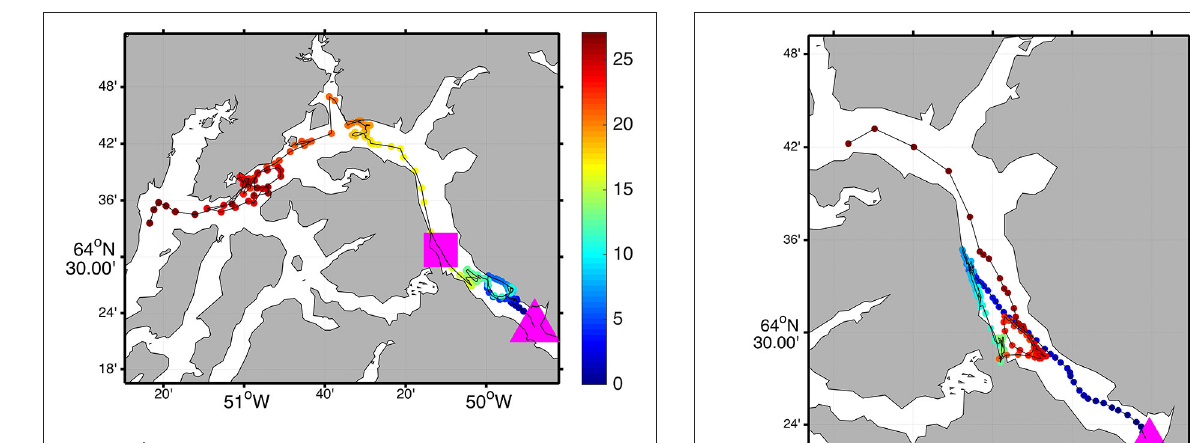
FIGURE 9 | A trajectory of an EXITE beacon initially deployed at the large pink triangle. Locations are color-coded according to time, in days, since deployment. Every 4th measurement is shown for clarity. The location where the critical acceleration was exceeded is indicated by the large pink square.